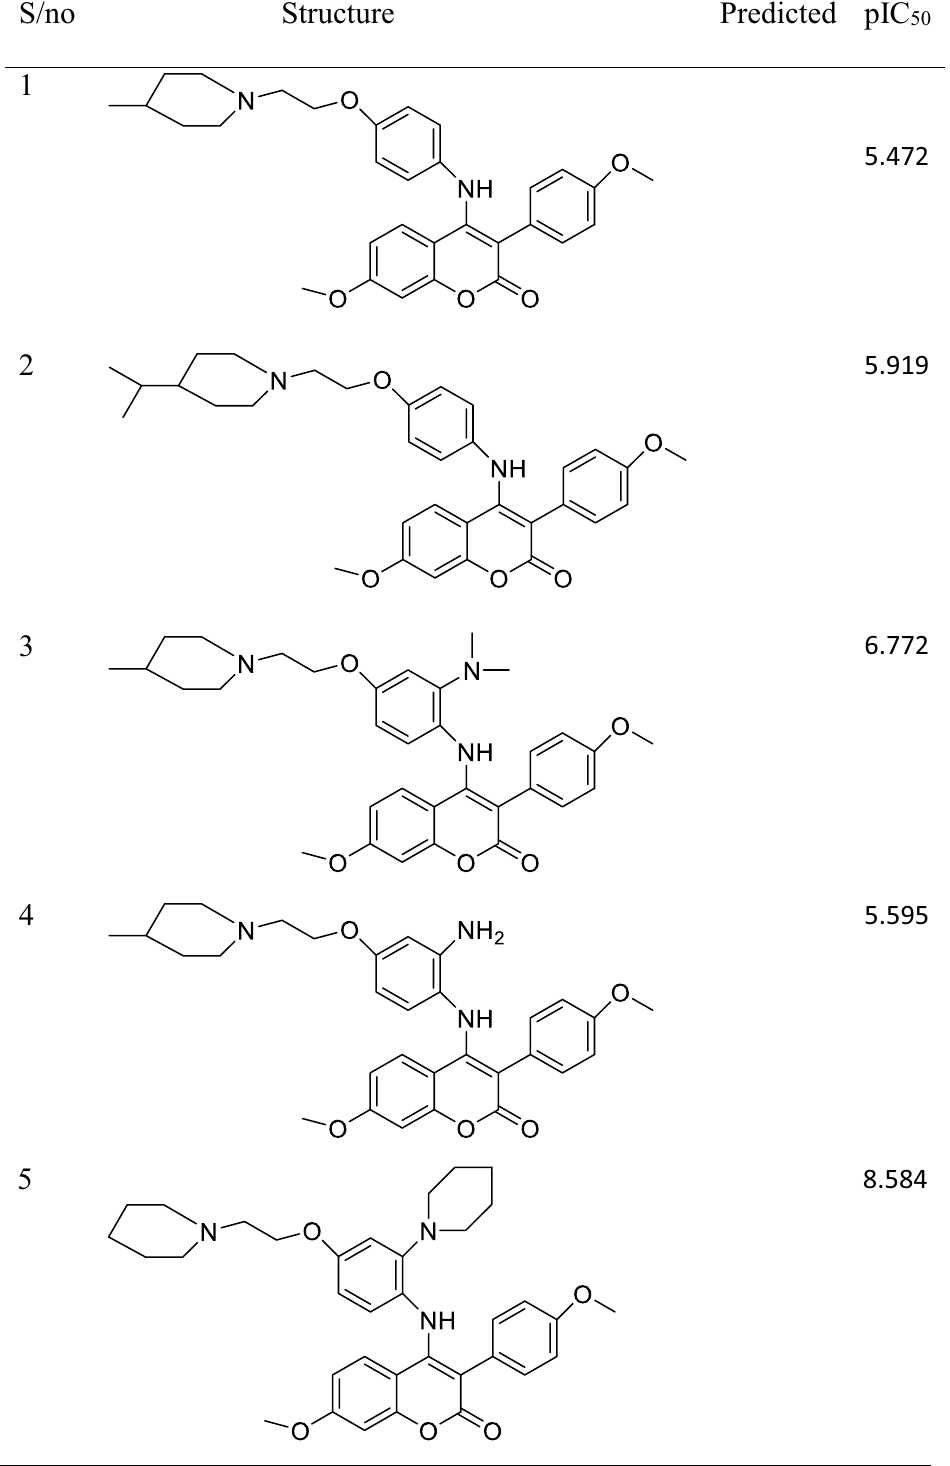
of the newly designed compounds pIC 50